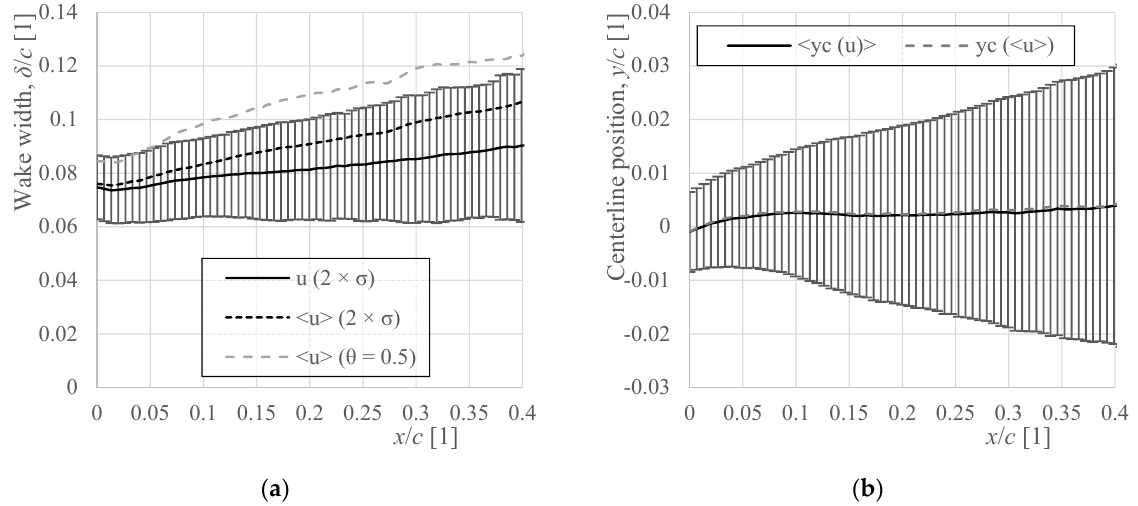
Figure 6. Panel ( a ) compares the wake width calculated as average of the instantaneous wake widths (Figure 5) with the wake width of ensemble-averaged stream-wise velocity by using the Gauss fit (black short-dashed line) and by using the threshold method (gray dashed line). The error bars represent the standard deviation of the instantaneous wake widths in each position. Panel ( b ) shows the position of wake centerline calculated on instantaneous (black solid line) or ensemble-averaged (gray dashed line) velocity field. Error bars are the standard deviation of the instantaneous wake positions.